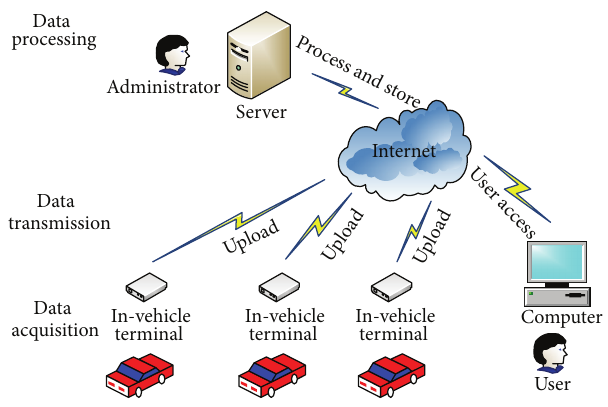
Figure 1: Car networking architecture in early